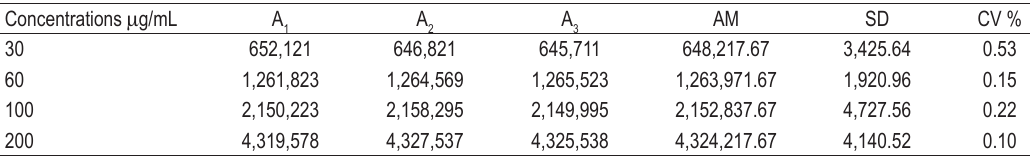
A B FIGURE 2. Selectivity of the analytical method was tested by comparing the blank sample chromatogram (A), the chromatogram of the homosalate standard (B), and the chromatogram of the homosalate containing sample at 306 nm (C). TABLE 3. Repeatability after 24 h